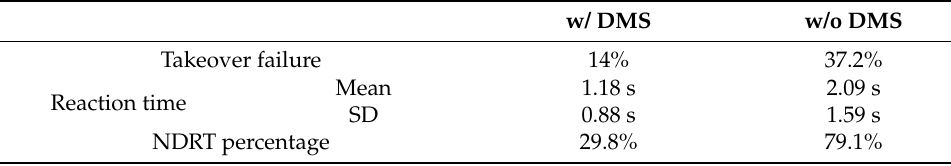
Figure 16. Driving results according to driver availability warnings ( n w / = 50, n w / o = 43). Table 4. Driving results according to the request to look forward.